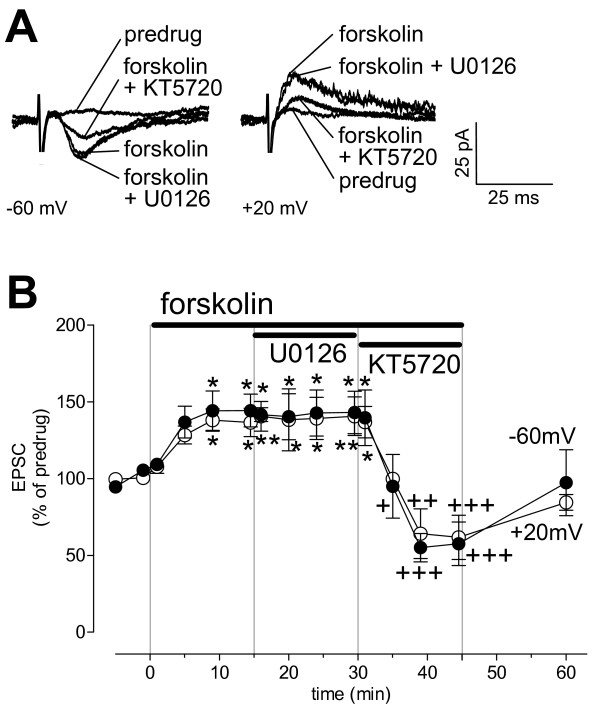
Synaptic facilitation by forskolin is not impaired by an ERK inhibitor (U0126). PKA activation by forskolin (5 μM, 15 min) increased transmission at the PB-CeLC synapse in slices from normal animals and induced an NMDA receptor-mediated component in the presence of NBQX (20 μM) and bicuculline (30 μM). U0126 (1 μM, 15 min) had no effect but KT5720 (1 μM, 1 min) inhibited the forskolin-induced facilitation. (A) Monosynaptic EPSCs (average of 8–10 traces) recorded in an individual CeLC neuron held at -60 mV and +20 mV. (B) Time course of drug effects at -60 mV and +20 mV (n = 4). Each symbol shows averaged EPSC amplitudes (mean ± SE) normalized to predrug control values (set to 100%). * P < 0.05, ** P < 0.01 (compared to predrug values), + P < 0.05, ++ P < 0.01, +++ P < 0.001 (compared to forskolin without KT5720; repeated-measures ANOVA with Bonferroni post-tests).